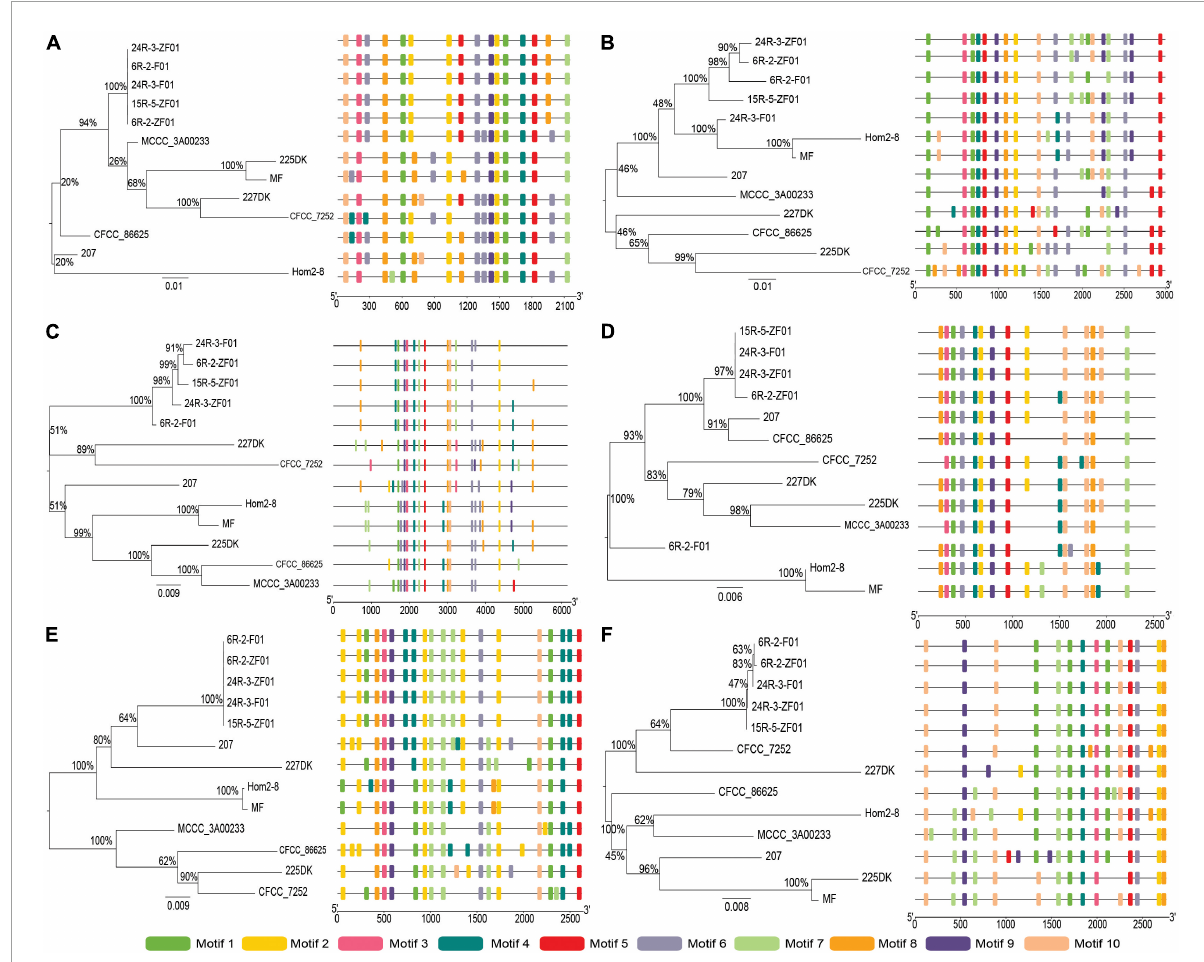
FIGURE3 Phylogenetic and motif compositions of the Schizophyllum commune population laccase gene family. (A–F) Represent neighbor-joining tree of ScLAC1-ScLAC6 protein sequences in S. commune population constructed using MEGA v7.0, and schematic motif composition of ScLAC1-ScLAC6 genes in S. commune population. The colored boxes represent the different motifs, indicated in the top right-hand corner. The scales at the bottom of the image indicate the motif length in